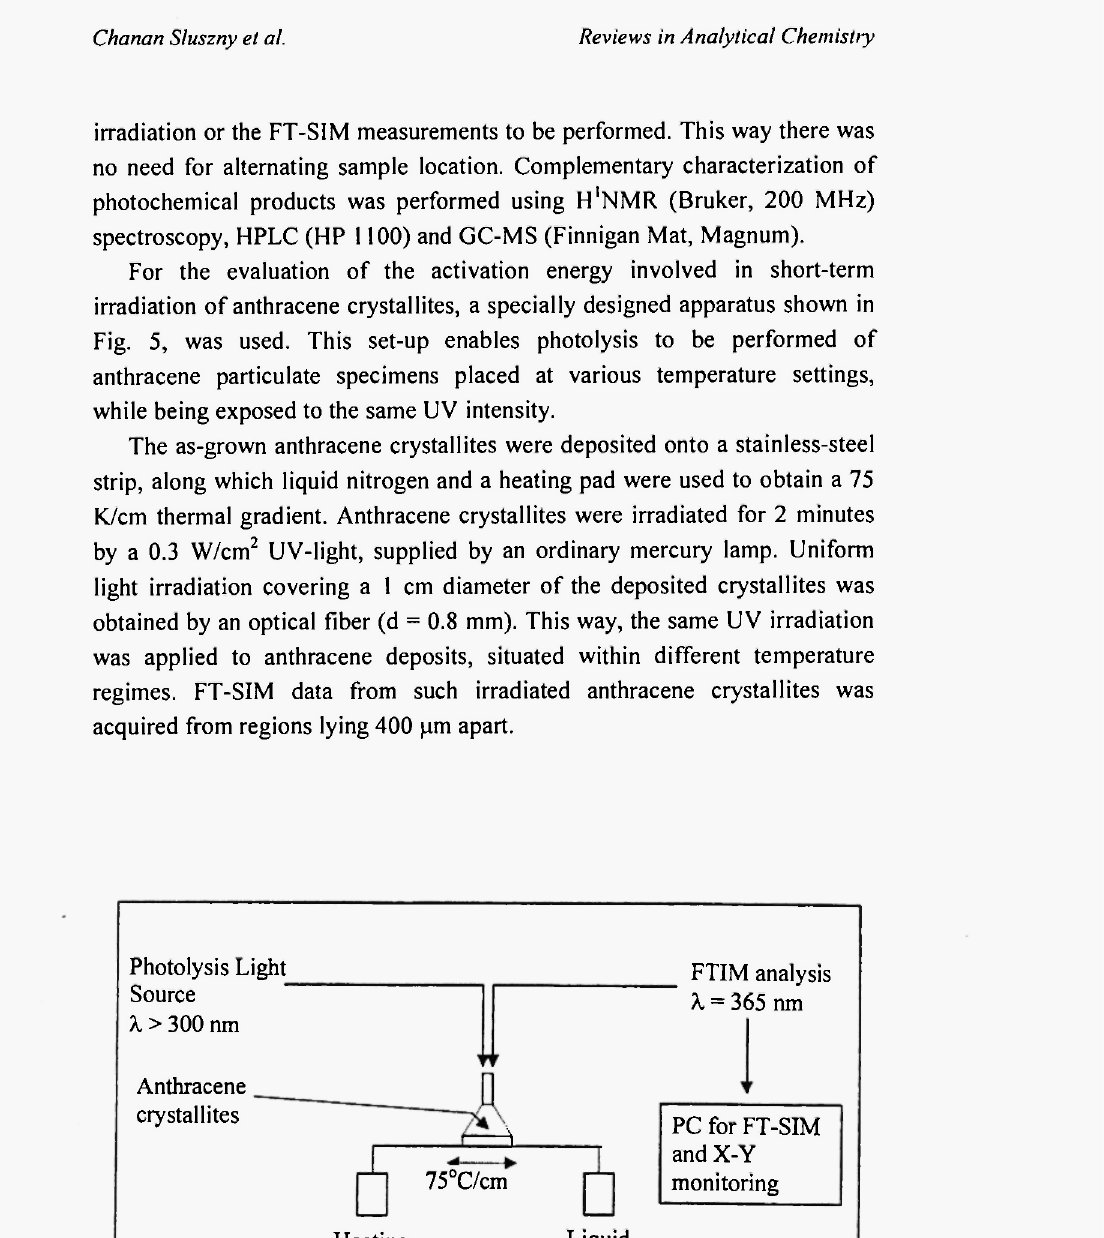
Fig. 5: Experimental set-up for thermally activated photolysis of